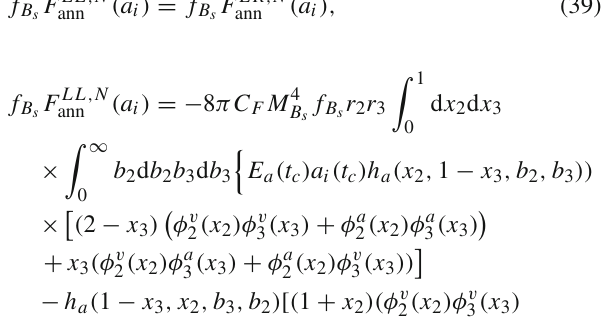
Fig. 3 Plot of r as a function of eter values of the CKM matrix elements for ¯ B 0 s → ρ 0 (ω)ρ 0 (ω) → π + π − π + π − . The dash line , dot line and solid line corresponds to r r + and r − , respectively